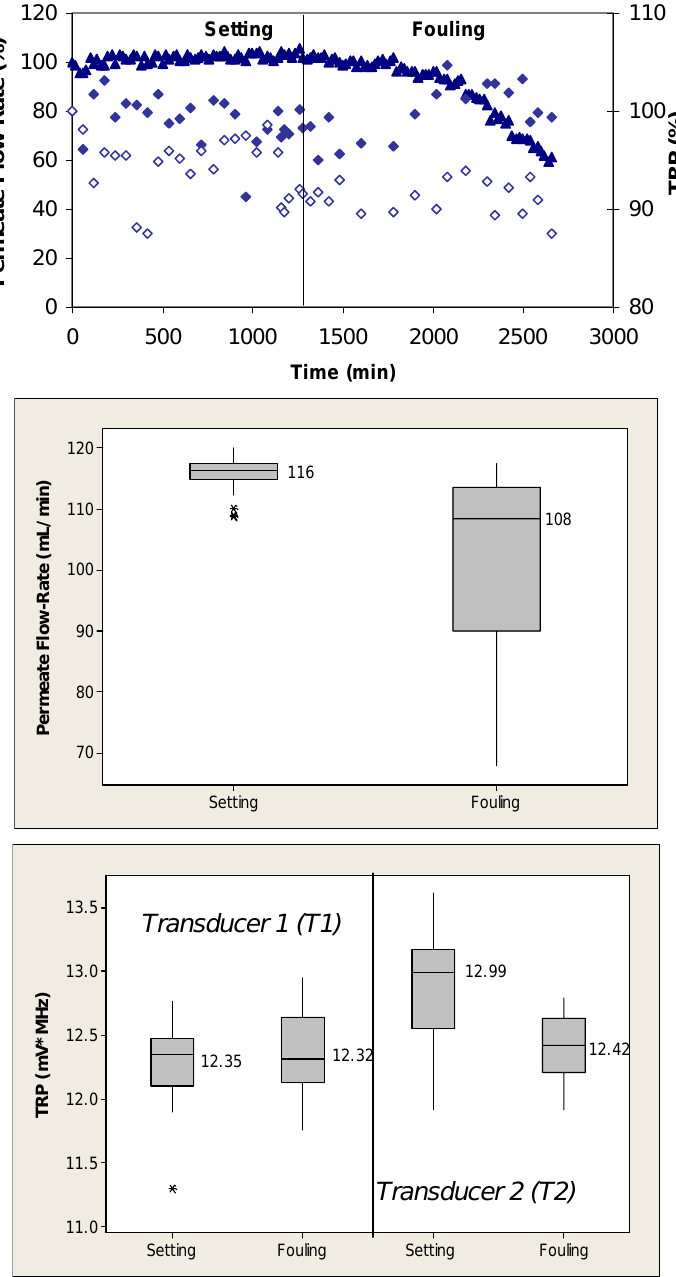
Figure 2. TOP: Permeate flow ( ▲ ) and total reflected power (TRP) from two transducers ( ♦ , ◊ ) associated with setting and fouling when PVDF membranes were challenged with 0.1 g/L BSA; maximum standard deviations from at least three independent observations are 25% and 6% for permeate flow and TRP, respectively. MIDDLE: Permeate flow data during the challenge represented in a box plot format where the vertical lines on the boxes indicate minimum and maximum observations; upper and lower quartiles are represented by the box boundaries and the median value is represented by the central intersecting line. BOTTOM: TRP distributions from each of two transducers mounted on the flow cells during the challenge represented in a box plot